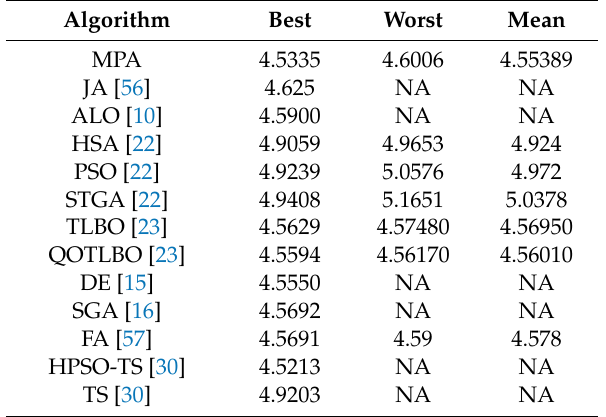
Table 3. Comparison of simulation results for P Loss